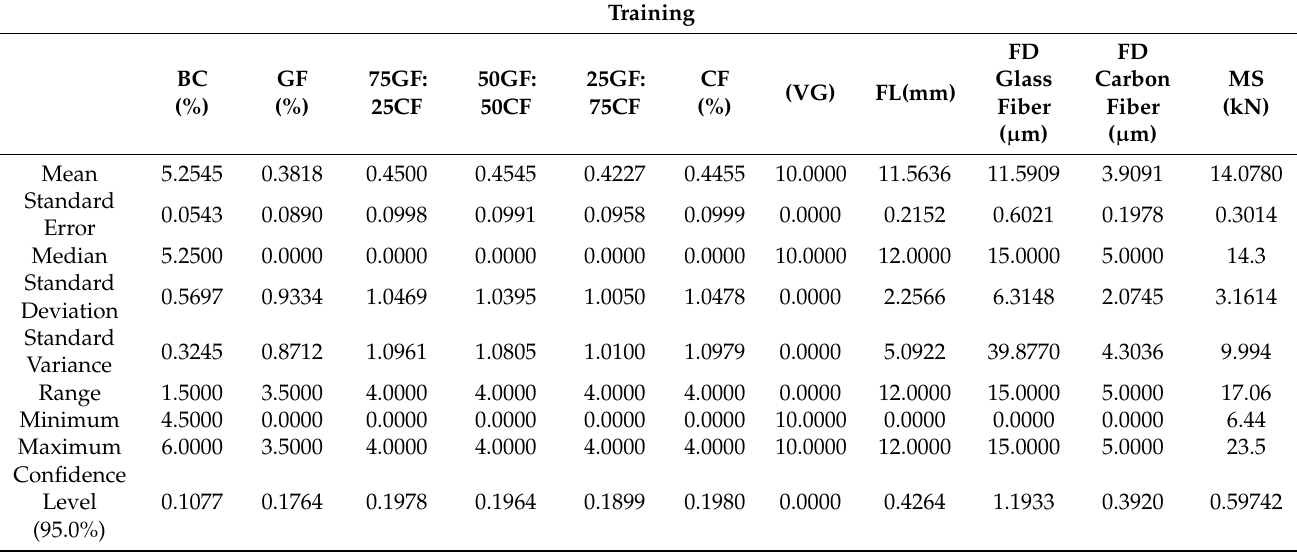
Table 10. Statistical characteristics of the